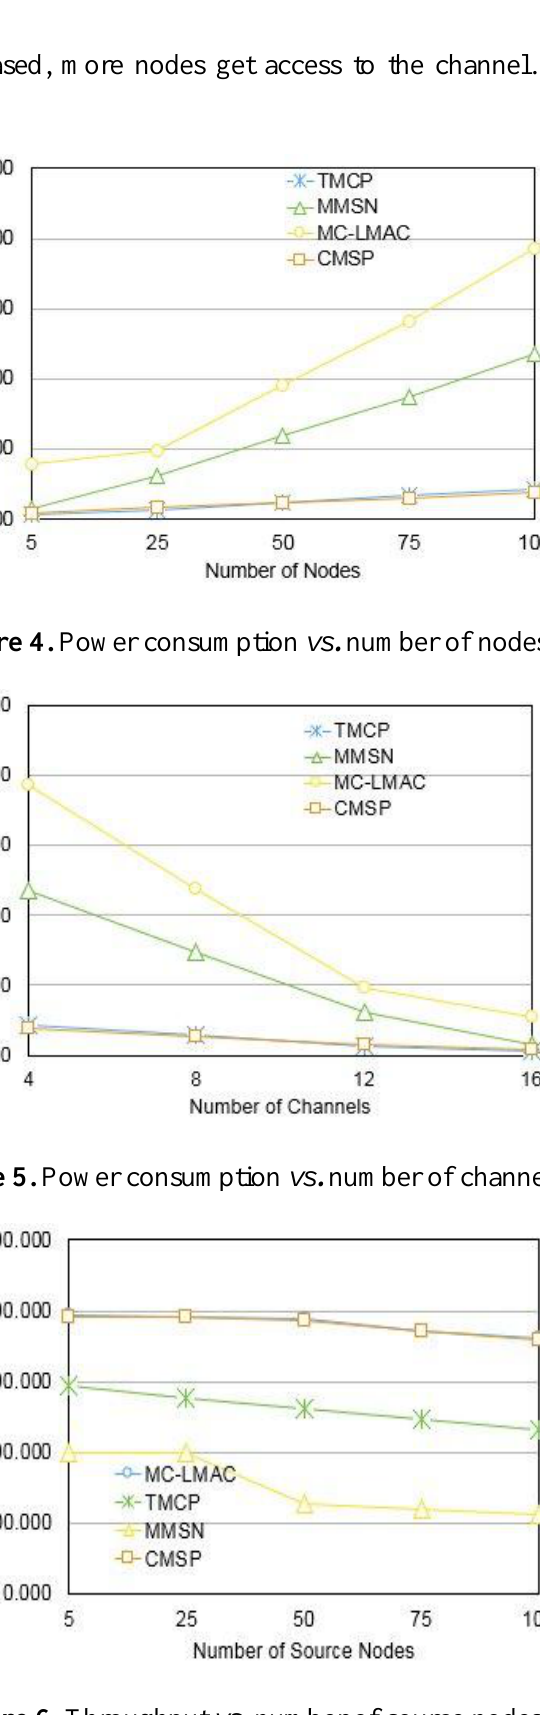
Figure 6. Throughput vs. number of source